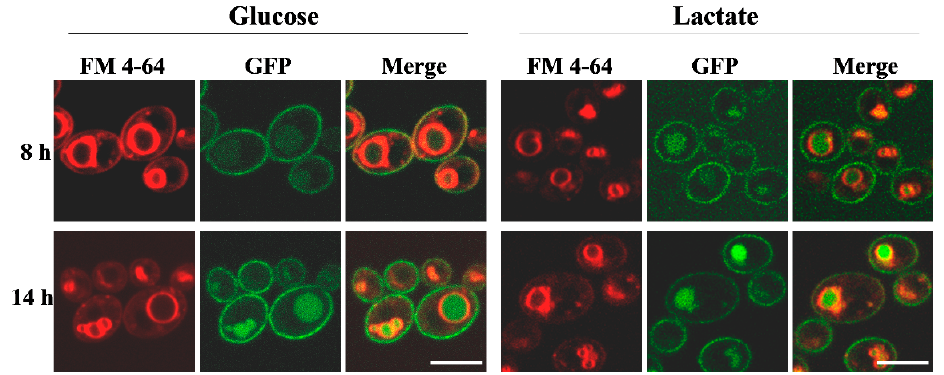
Figure 3. Confocal micrographs of vacuolar membrane staining (FM 4-64) and subcellular localization of CDR1 - GFP protein in C. albicans ASCa1 ( CDR1-GFP ) strain during growth (8 and 14 h) in YPD (glucose) or YPL (lactate) medium. A merged image of the GFP -tagged protein and FM 4-64 staining is shown in the third and sixth columns. Scale bar = 5 µm.